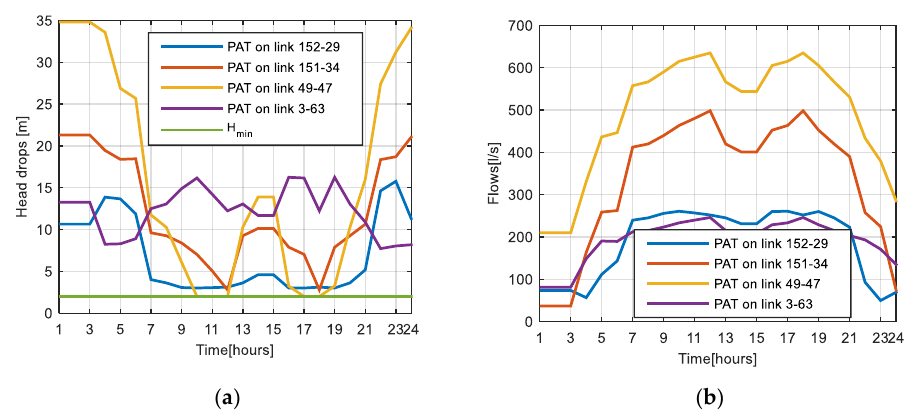
Figure 11. The hourly head drops ( a ) and flows through the PATs ( b ).